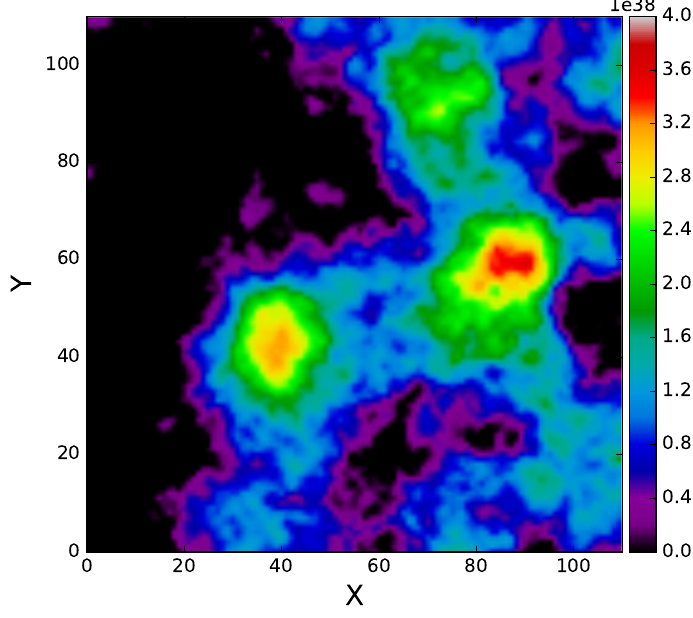
Figure 5. Galaxy subtraction for the bullet cluster. There is galaxy contributions for both the main cluster and